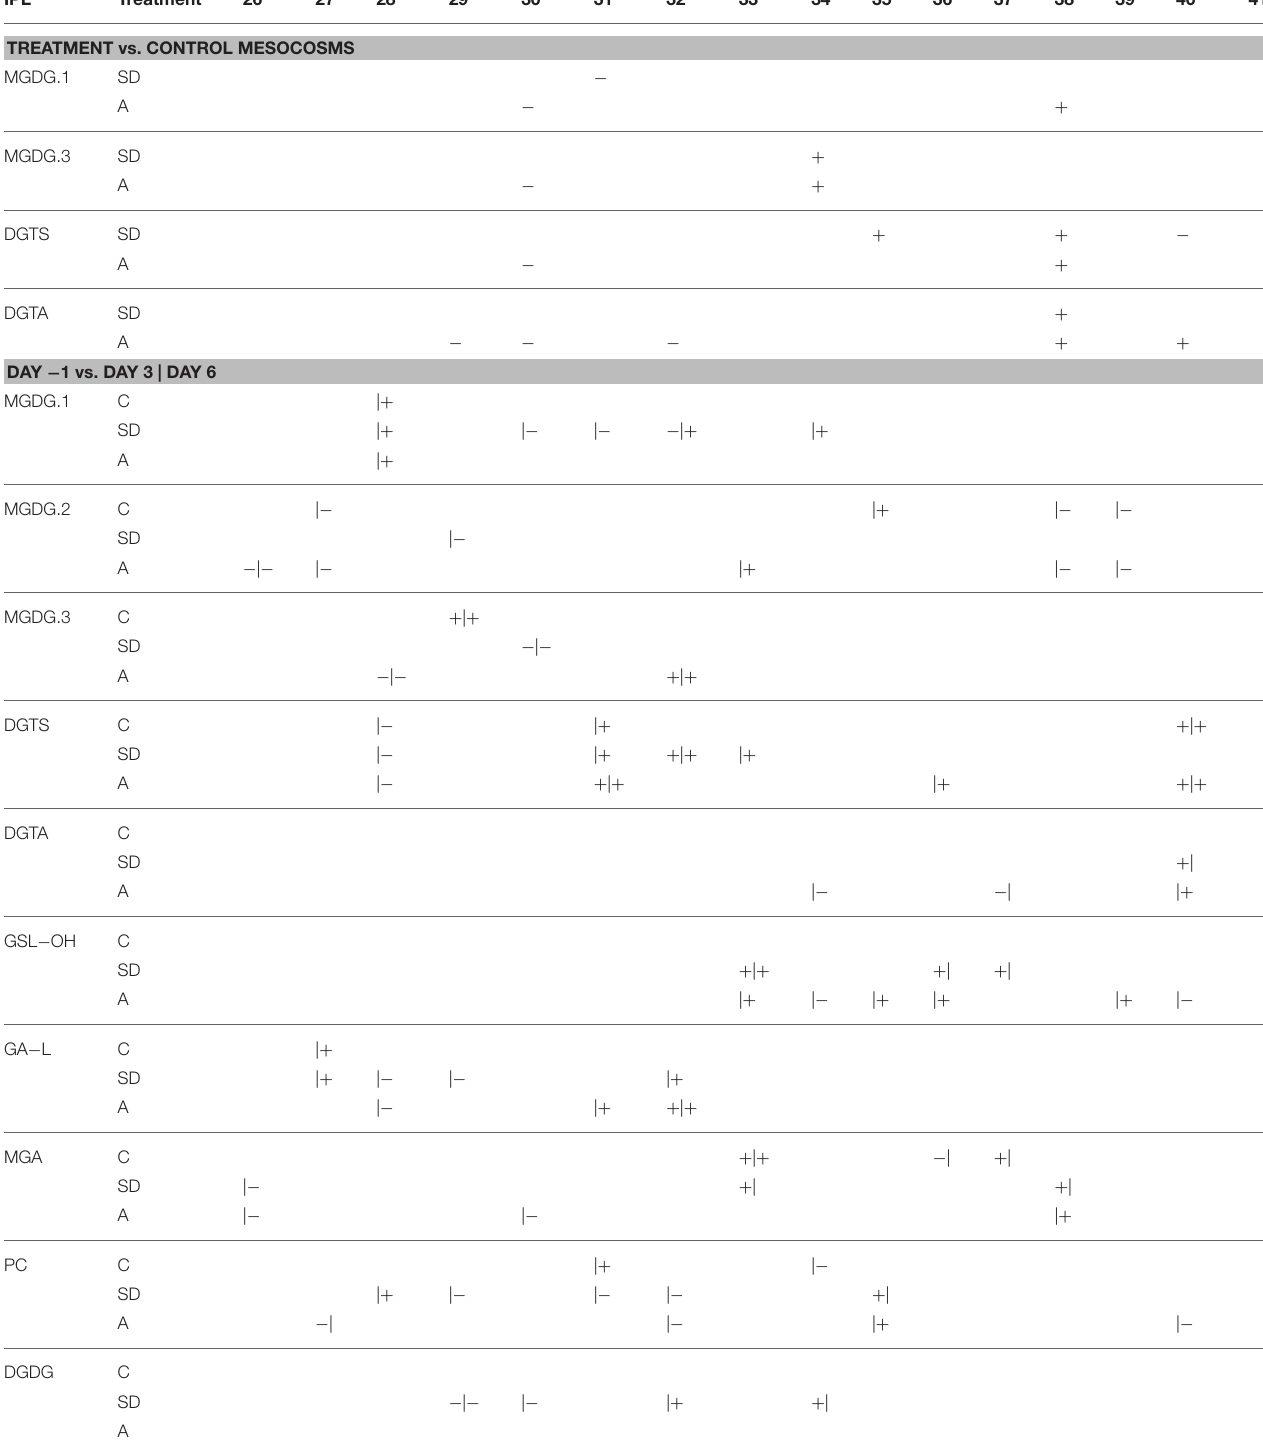
Comparisons refer to the average chain distributions in Saharan dust (SD) or mixed aerosol (A) vs. control (C) mesocosms or between days − 1 and day 3 or 6 in the same treatment. The absence of an IPL class in the table is indicative of no significant change.